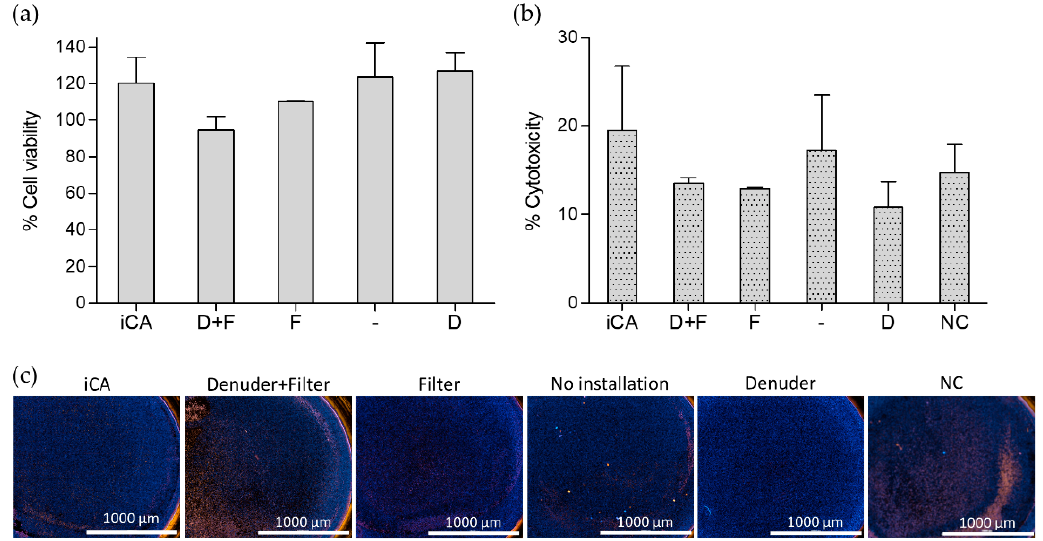
Figure A4. Effect of the new ALI exposure system with its different installations on A549 cells upon 24 h exposure to clean air ( n = 2). ( a ) Percentage cell viability normalized to the NC, and ( b ) percentage cytotoxicity compared to the NC measured by normalization to the total LDH release (2% Triton X-100 positive control). ( c ) Live cell imaging with 5 µ g/mL H 33342 to stain the nuclei (blue) and 2.5 µ g/mL propidium iodide (red) to selectively stain dead cells. iCA = independent clean air, NC = negative control. Installations: F = Filter; D + F = Denuder + Filter; D = Denuder; No installation= ( − ).